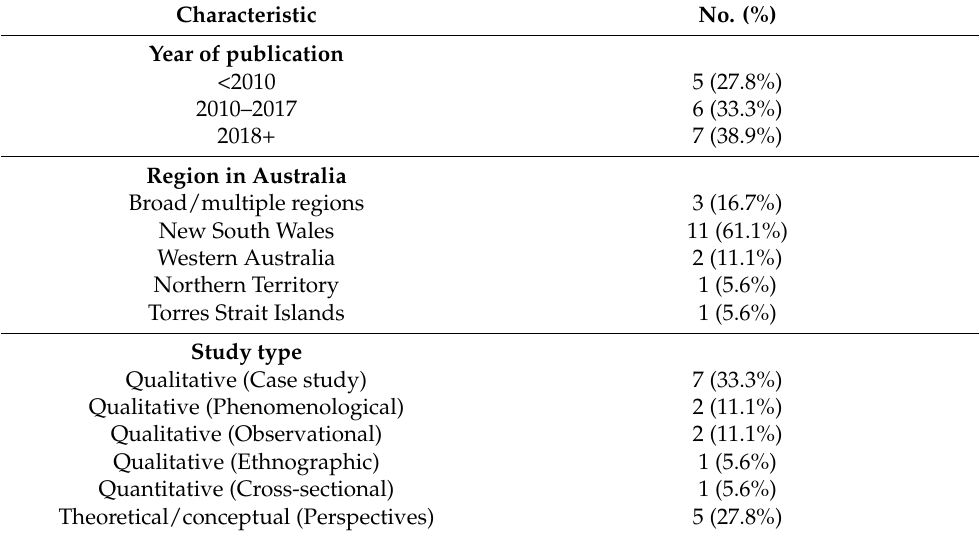
Table 2. General Characteristics of Included